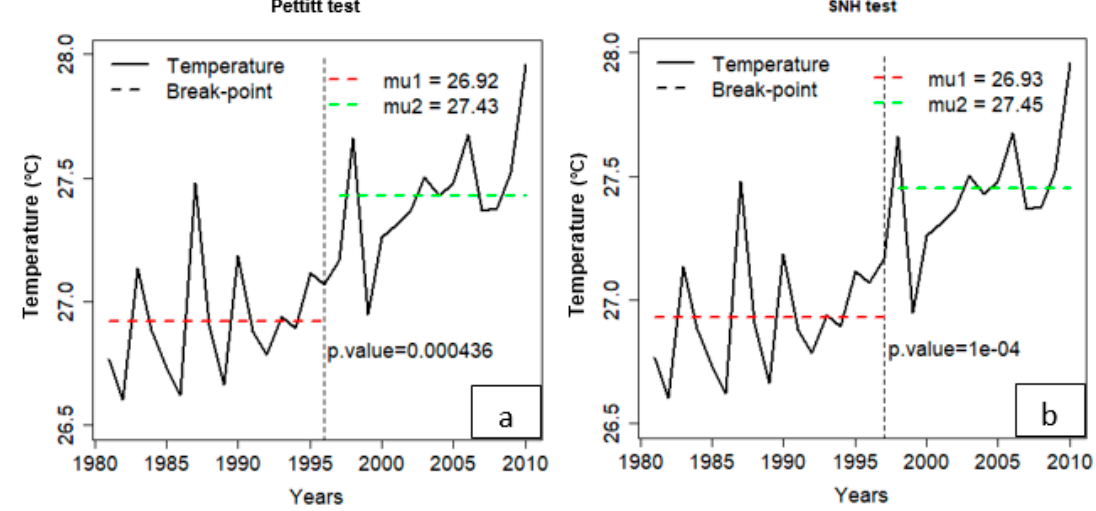
Figure 8. Pettit test ( a ) and SNH test ( b ) performed on annual temperature over the period 1981–2010.